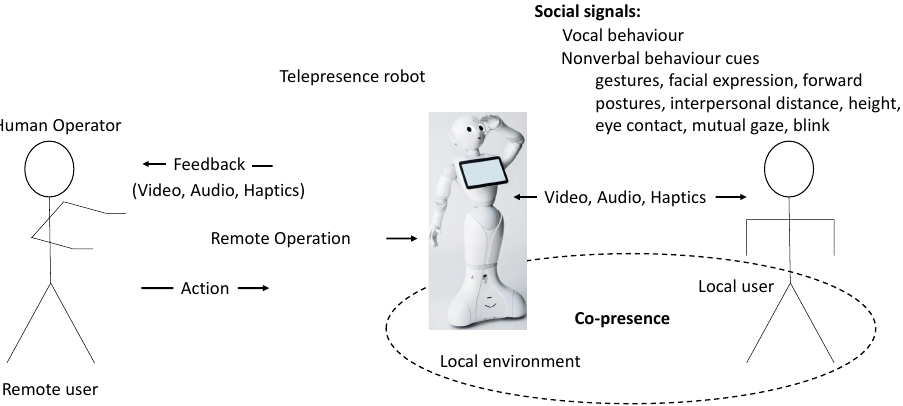
Figure 1. Interaction scenario with telepresence and